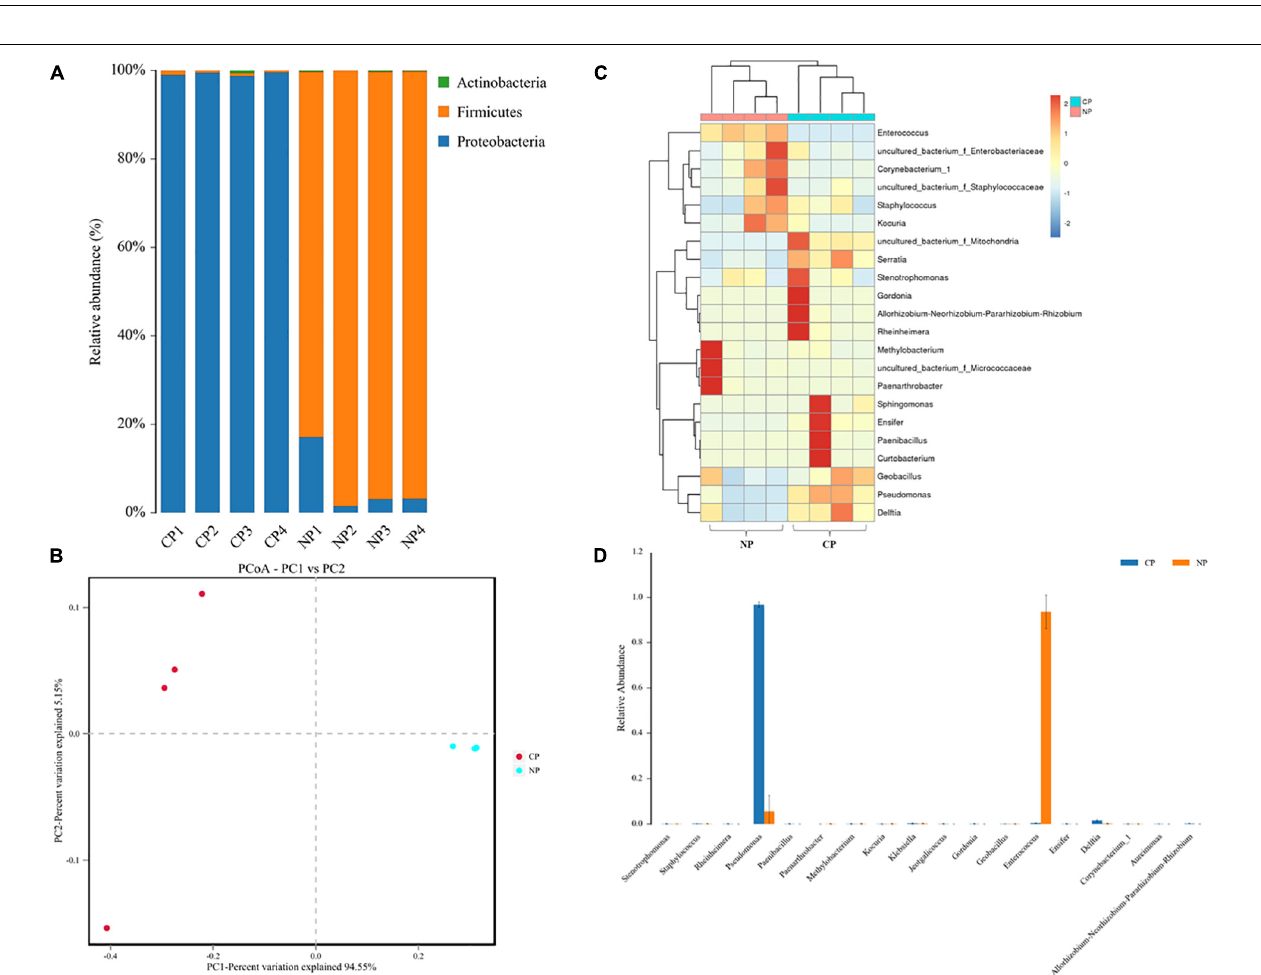
FIGURE 2 | Parasitism alters the gut bacterial community composition. (A) The color-coded bar plot of the average bacterial phylum distributed between parasitized larvae and non-parasitized larvae. (B) Principal coordinate analysis (PCoA) of symbiotic bacterial communities in the gut of parasitized larvae and non-parasitized FAW larval plots based on Bray–Curtis metric (PERMANOVA test, R 2 = 0.922, p = 0.03). (C) Heat map in log scale depicting the relative abundance of the top 20 shared genera and genus, with cluster analysis using the Bray–Curtis distance, followed by a complete-linkage method. (D) Relative abundance of bacteria at the genus level was compared between parasitized caterpillars and non-parasitized caterpillars using a nonparametric Wilcoxon rank-sum test. NP, caterpillars without parasitism; CP, caterpillars parasitized by C . marginiventris .